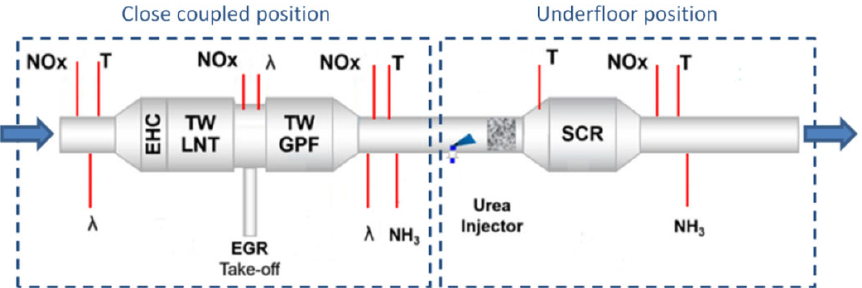
Figure 1. Future ‐ proof exhaust after ‐ treatment system for Euro 7, where EHC (48 V, 3 kW), TW Figure 1. Future-proof exhaust after-treatment system for Euro 7, where EHC (48 V, 3 kW), TW LNT—for cold start, TW GPF ( η > 90%, PM > 10 nm), SCR (T > 140 °C) NOx—ammonia sensor, T— LNT—for cold start, TW GPF ( η > 90%, PM > 10 nm), SCR (T > 140 ◦ C) NOx—ammonia sensor, temperature sensor, λ —lambda sensor (adapted from [29,30]). T—temperature sensor, λ —lambda sensor (adapted from [29,30]).